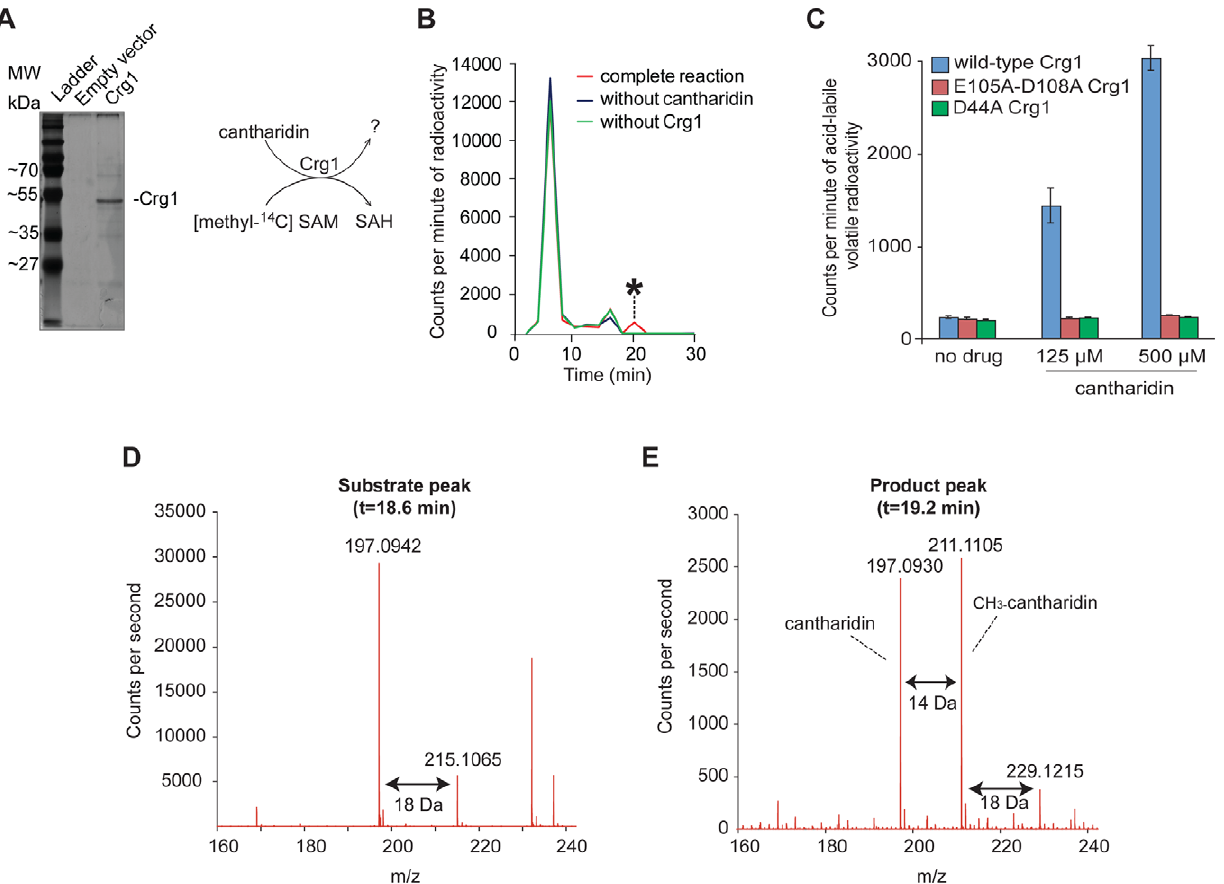
Figure 3. Crg1 methylates cantharidin invitro . (A) Silver stained 12% SDS-PAGE of purified His-tagged Crg1. Wild-type cells (Y258) carrying empty vector BG1805 and BG1805-GAL1-CRG1 were grown in SD-URA and raffinose (2%) to mid-exponential phase. The expression of CRG1 was induced with galactose (2%) for 5 hours. His-tagged Crg1 was purified with Ni-sepharose resin. The diagram (right panel) shows the transfer of [ methyl - 14 C] from S -adenosyl-[ methyl - 14 C]methionine to a potential substrate by purified Crg1. (B) In vitro enzymatic reaction mixtures containing cantharidin, S -adenosyl-[ methyl - 14 C]methionine, and Crg1 were separated by reverse phase chromatography. Radioactivity in the fractions was quantified with a scintillation counter, and a cantharidin and Crg1-dependent peak with a retention time of 18–20 minutes was identified (asterisk). (C) In vitro analysis of the reactions containing cantharidin and mutated forms of Crg1 by measurement of the amount of acid-labile volatile radioactivity (see Materials and Methods for details). (D) Additional in vitro reaction with unlabeled SAM were prepared in a similar manner and analyzed by liquid chromatography-mass spectrometry with positive ionization. The mass spectrum of the peak from the full reaction with an elution time of 18.6–18.8 minutes is shown. (E) The mass spectrum of the peak with an elution time of 19.2 minutes from the complete reaction with cantharidin, SAM and Crg1.